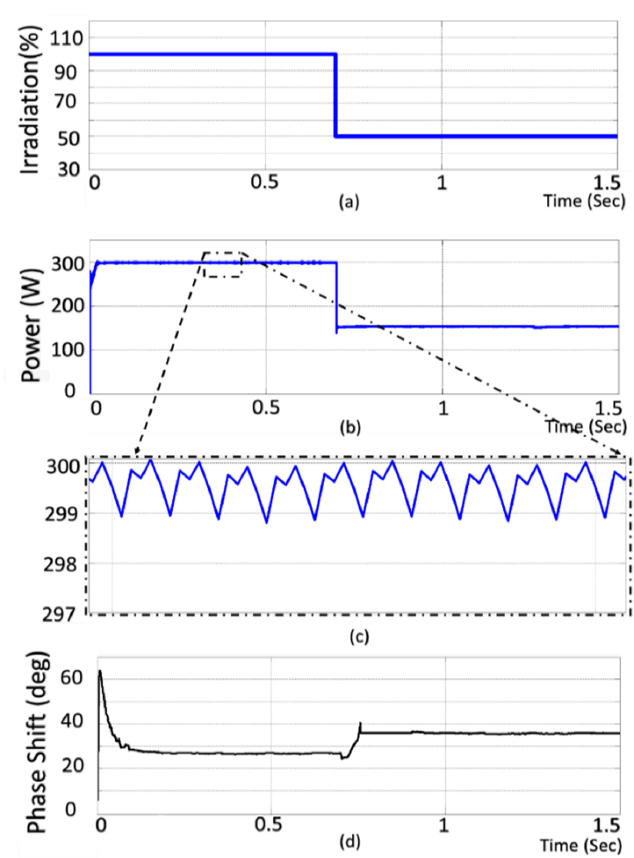
Figure 8. The proposed variable step FFPS predictive MPPT control: ( a ) the irradiation profile ( b ) the PV input power and the maximum power ( c ) the power oscillation ( d ) the phase-shift change.